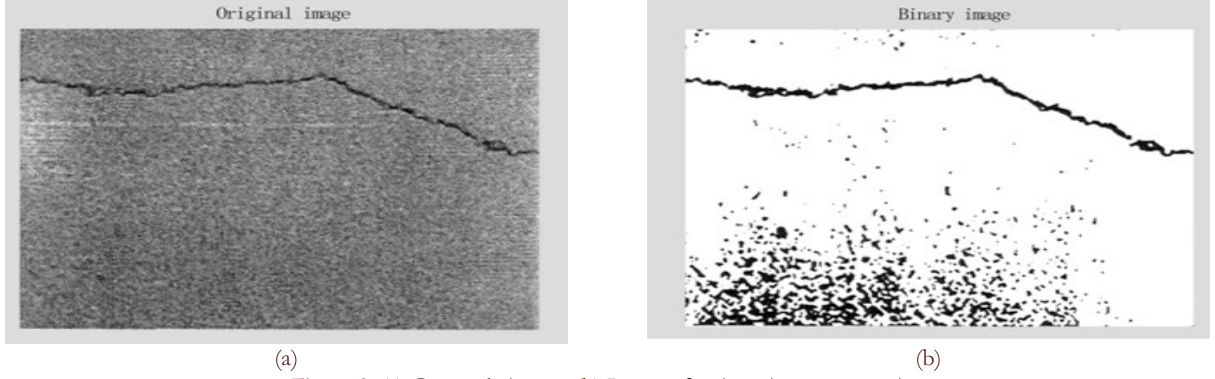
Figure 3: (a) Grayscale image; (b) Image after iterative